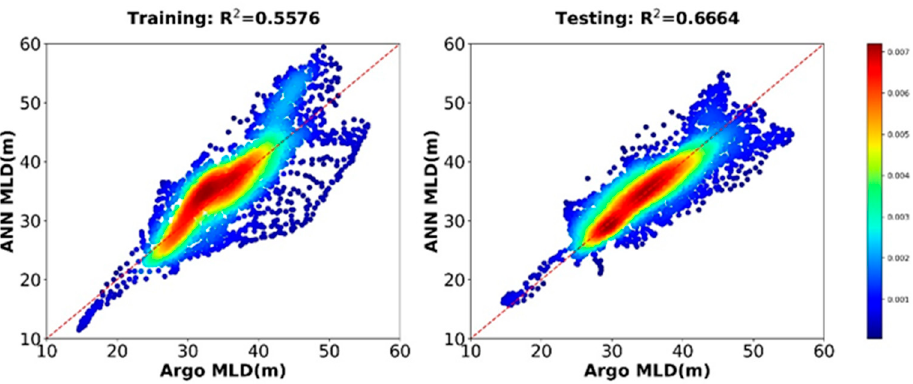
Figure 5. The training and testing performance of the ANN model using multisource observation da ‐ tasets.